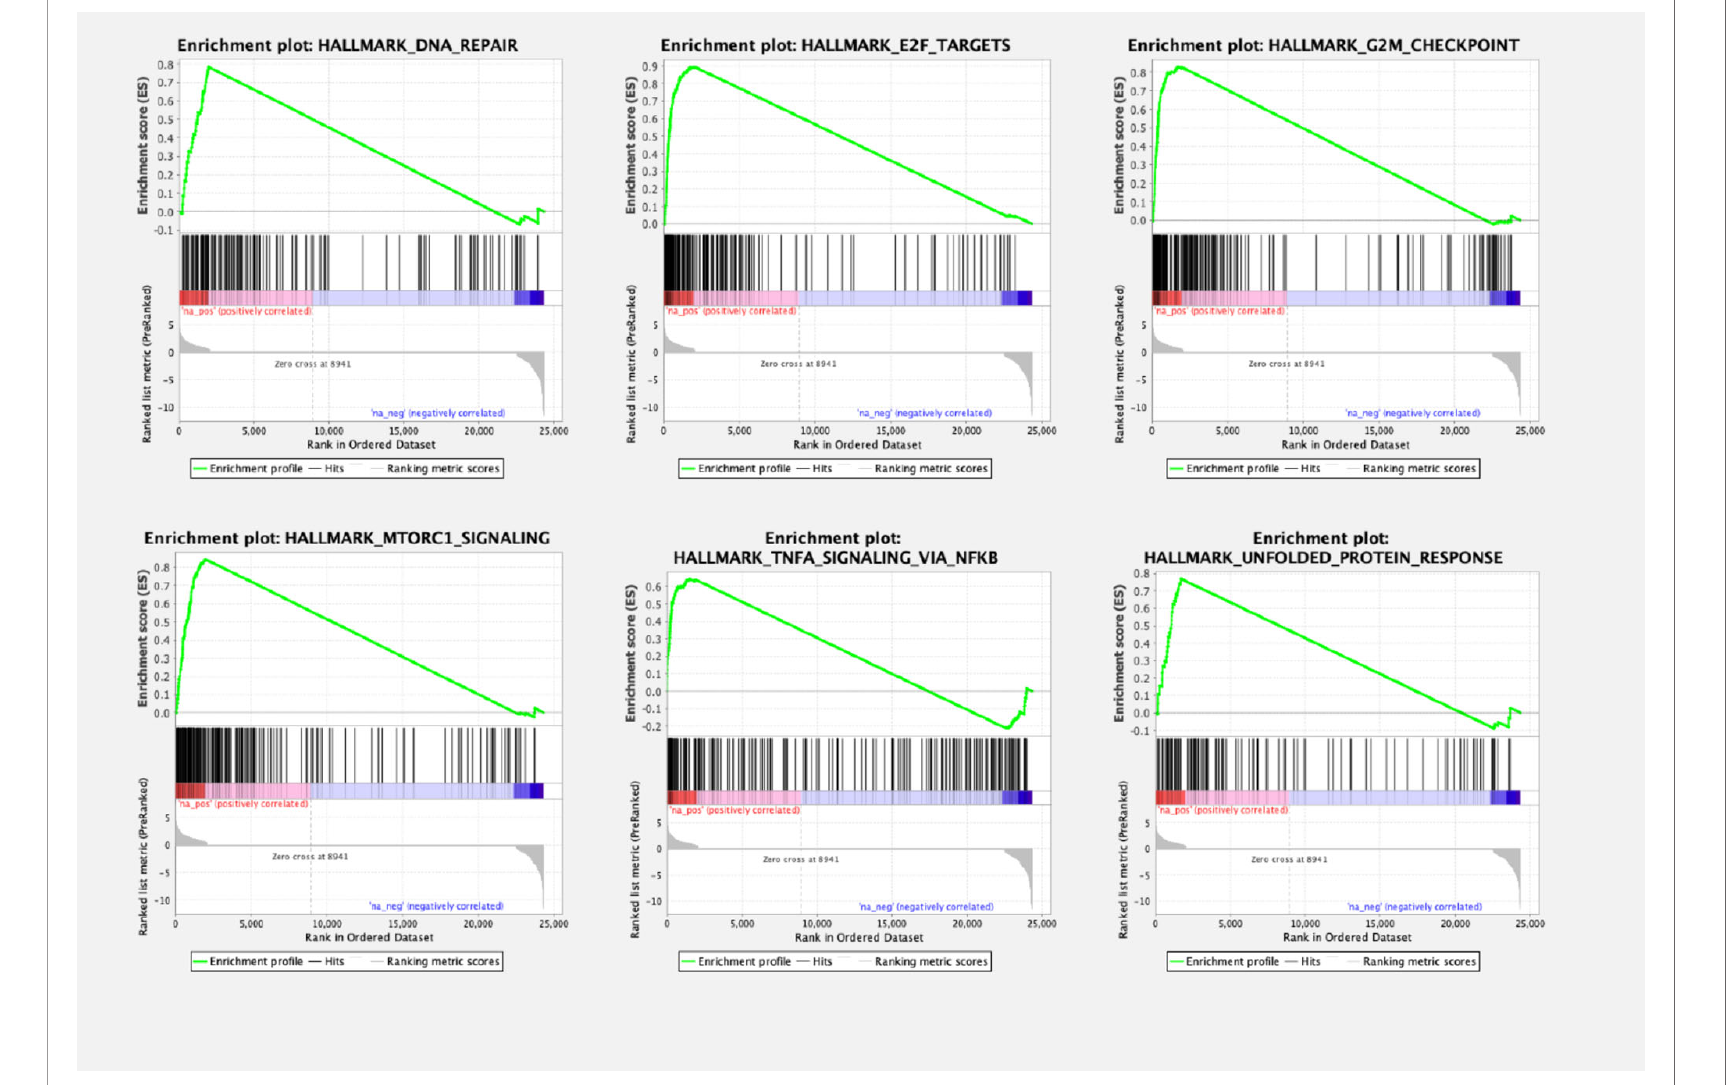
FIGURE 3 | Gene set enrichment analysis (GSEA) plots of enriched pathways in ccRCC primary cell cultures compared to the tissue of origin. Gene set enrichment analysis revealed several pathways being signi fi cantly dysregulated, among them pathways involving genes of DNA repair mechanisms. Signaling of E2F and G2M checkpoint regulation, therefore involved in cell cycle regulation, was also dysregulated, as well as MTORC1- and TNFA pathways, other signaling cascades regulating cell